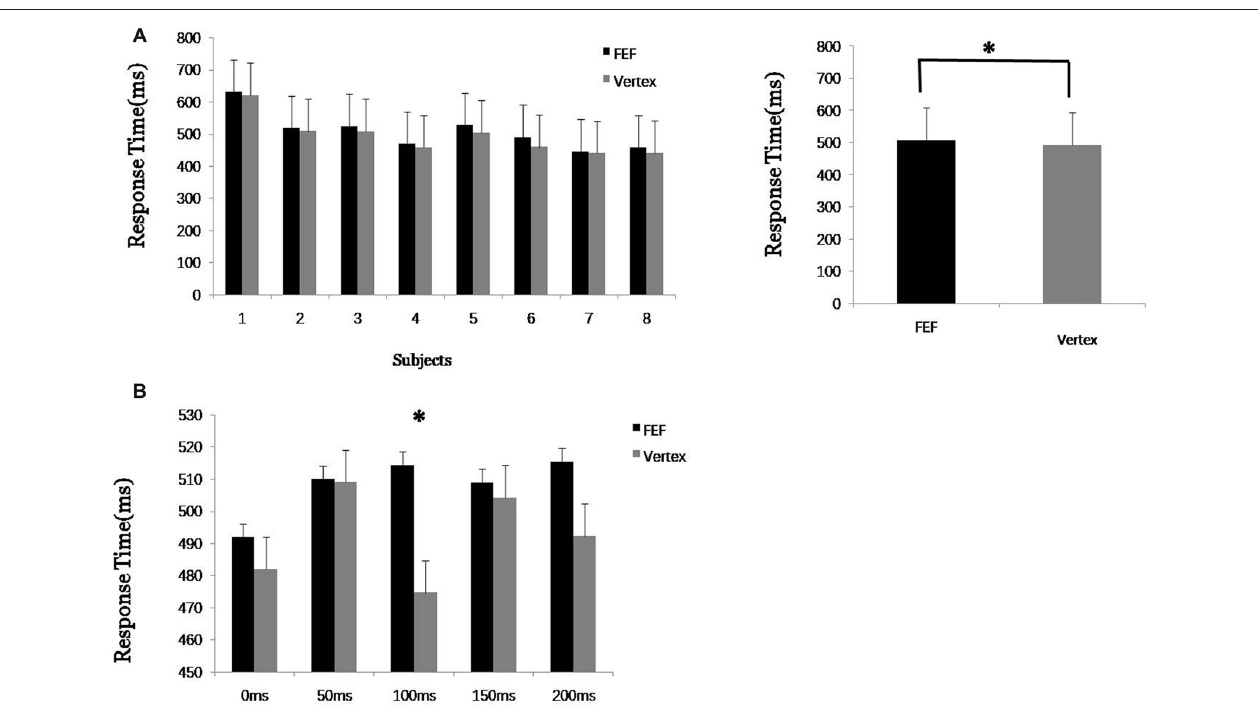
FIGURE 2 | Experiment 1 results. (A) Average response time of each eight subjects to transcranial magnetic stimulation (TMS) applied to the right frontal eye field (FEF) and vertex. (B) Response time after TMS at 0, 50, 100, 150 and 200 ms from the beginning of the first visual target stimulus. “ ∗ ” means significantly different ( p <